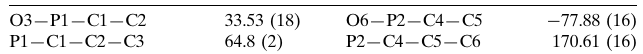
Selected torsion angles ( (cid:4) ).